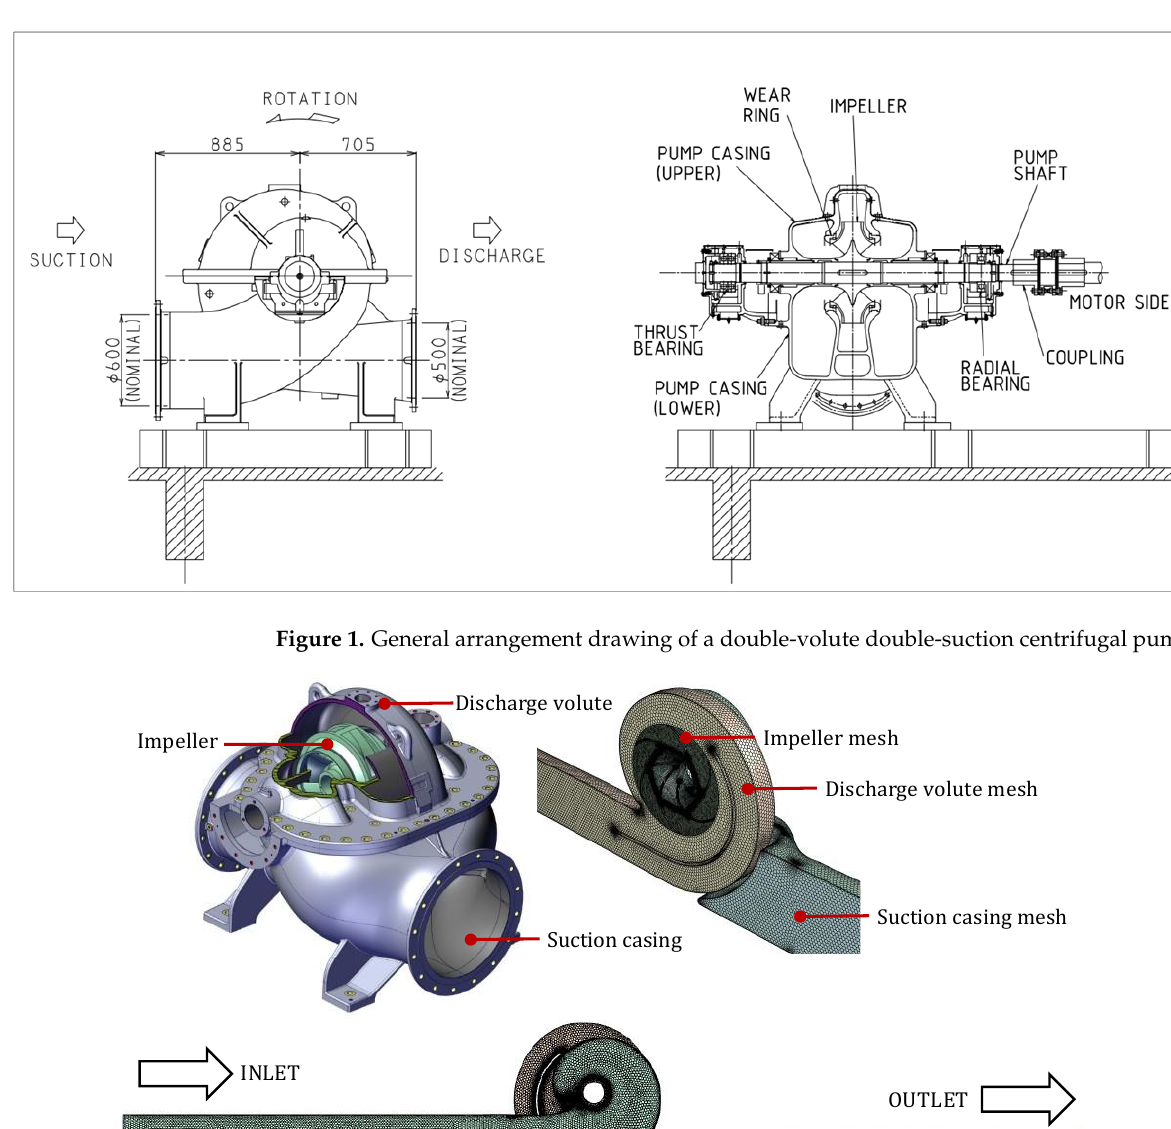
Figure 1. General arrangement drawing of a double-volute double-suction centrifugal pump.